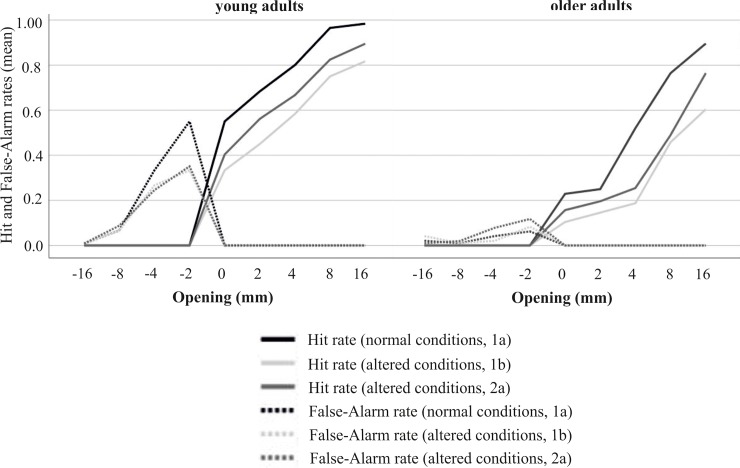
Hit and False-Alarm rates for passive hand judgments separated for age groups.Graphs show the distribution of Hit and False-Alarm rates over openings. In order to display the adaptation processes, one line per session was depicted. (1a = normal body properties, 1b = altered body properties directly after splinting of the hand, 2a = altered body properties after 24h of wearing the hand splint).